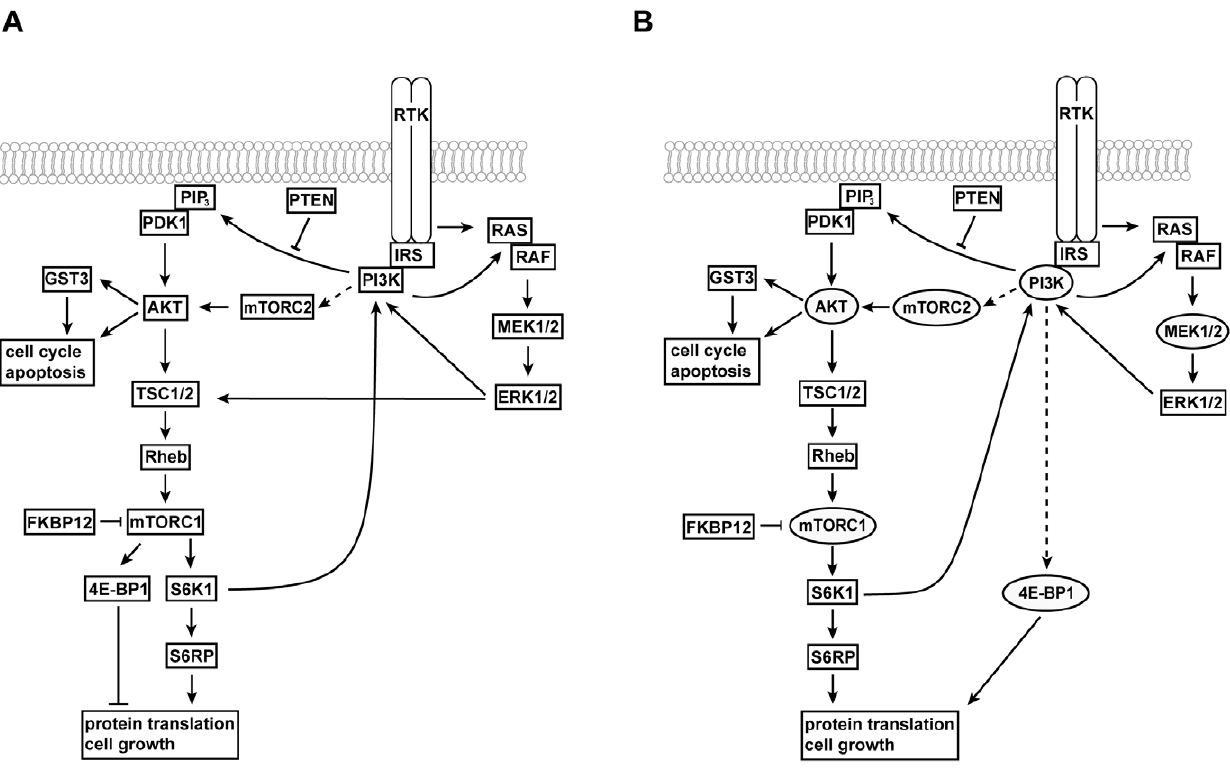
Figure 7. Schematic representation of the PI3K/Akt/mTOR and MAPK signaling pathways in urothelial carcinoma. A: In the current model, activation of PI3K results in activation of Akt via mTORC2 and PDK1, a process that can be reversed by PTEN. Subsequently, Akt regulates amongst other proteins TSC1/2 that together with RHEB control mTORC1 and its downstream targets S6K1 and 4E-BP1. Both molecules are involved in the regulation of protein translation and cell proliferation. Crosstalk between the PI3K and the MAPK pathway has been demonstrated from PI3K/ IRS to RAS and from ERK1/2 to TSC1/2 and PI3K. B: According to the present results, in urothelial carcinoma mTORC1 regulates activity of S6K1/S6RP whereas 4E-BP1 activation status is regulated via PI3K. Both, 4E-BP1 and S6K1 are involved in regulating cell proliferation. Inactivation of PI3K and also S6K1 results in phosphorylation of RAS and ERK1/2. The inhibition of MEK1/2 induces Akt but neither S6K1 nor 4E-BP1 phosphorylation. Potential target molecules and stratification marker are shaped elliptical.